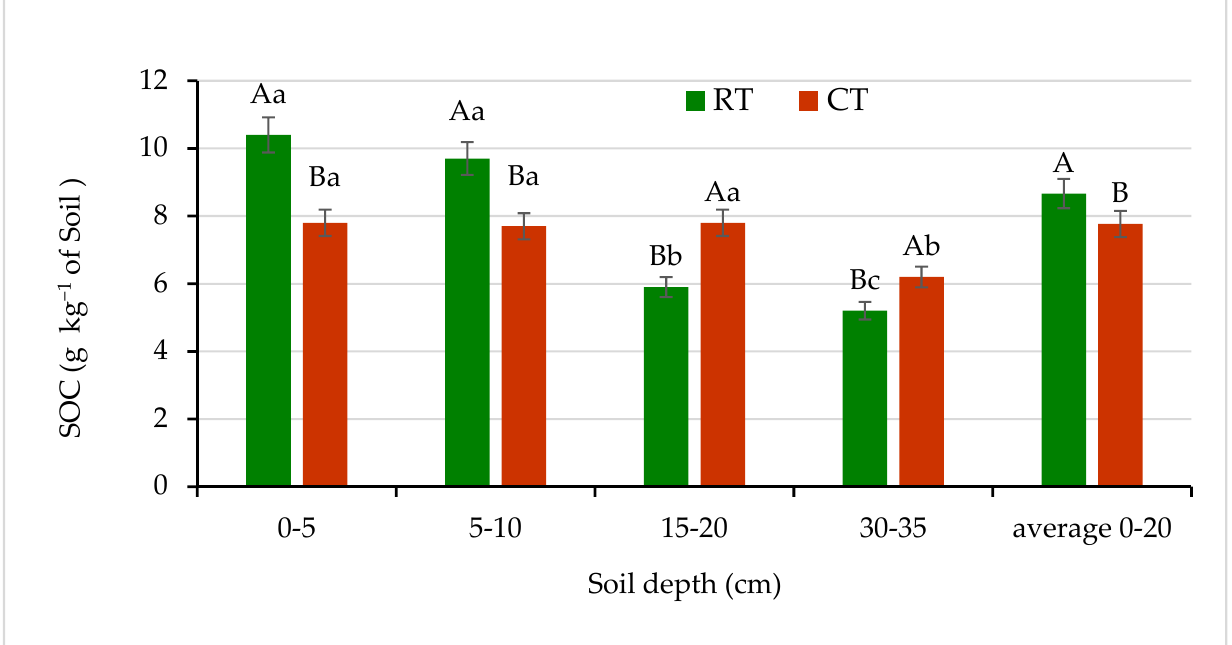
Figure 4. Soil organic carbon (SOC) content in soil under different tillage systems in 2018–2020 (expressed as means for the 3 years, n = 12). Different letters represent significant differences ( p ≤ 0.05) across treatments according to Tukey’s HSD test; lowercase letters within the same tillage system indicate significant differences between soil depths; uppercase letters indicate differences between tillage systems. RT—reduced tillage system; CT—conventional tillage system; n— number of samples. Vertical bars represent standard errors.